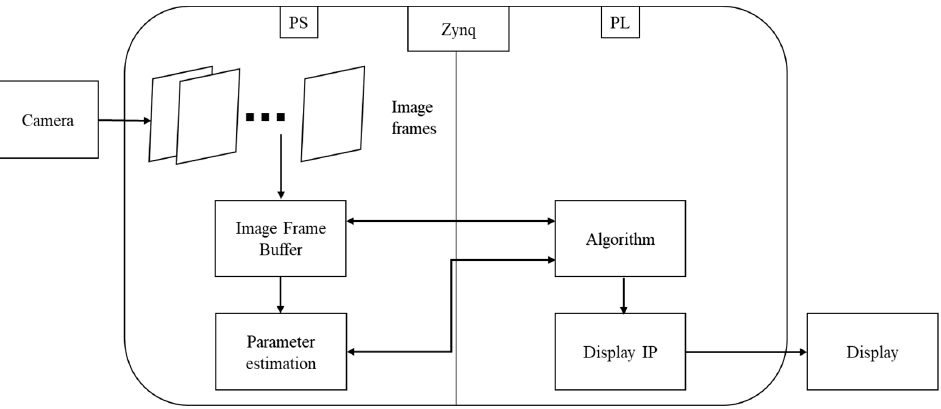
Figure 5. Idea of implementation flow in Zynq board.